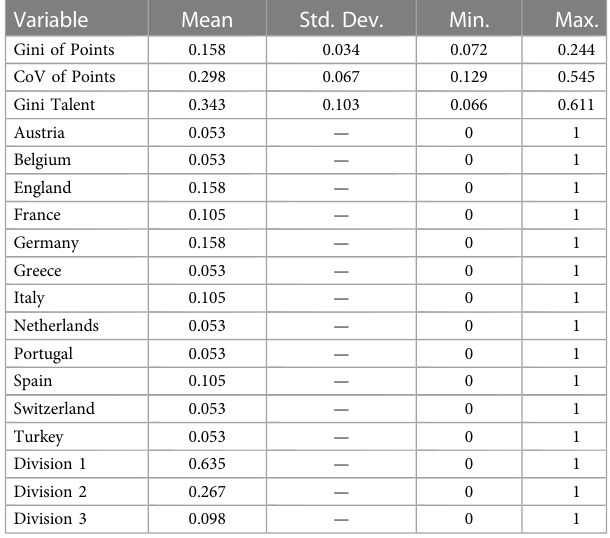
TABLE 1 Composition of the dataset. Country Divisions and number of teams Number of